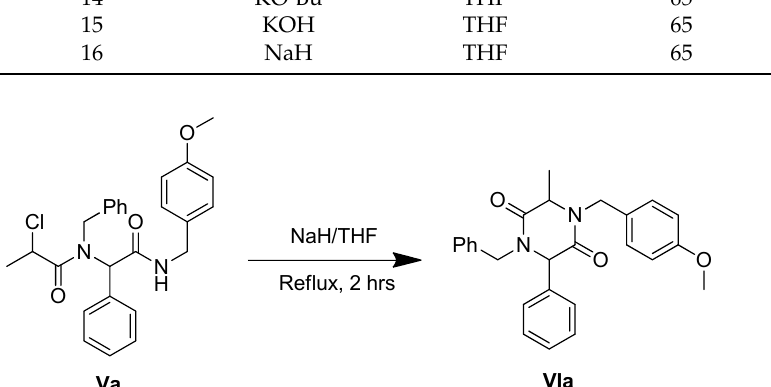
Scheme 3. Model cyclisation reaction.